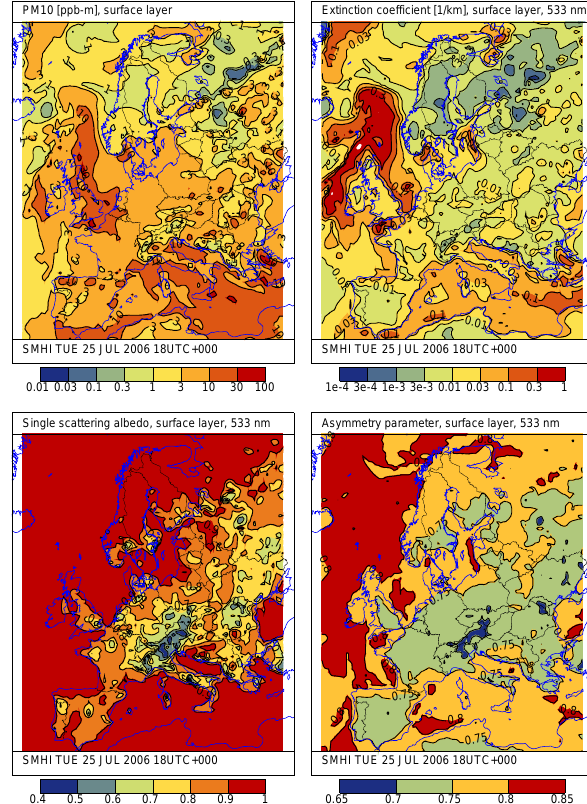
Fig. 9. PM 10 mass mixing ratio (upper left), extinction coefficient (upper right), single scattering albedo (lower left), and asymmetry parameter (lower right) on 25 July 2006, 18:00 UTC. The optical parameters are shown for λ = 533 . 2nm. All results are shown for the model layer closest to the